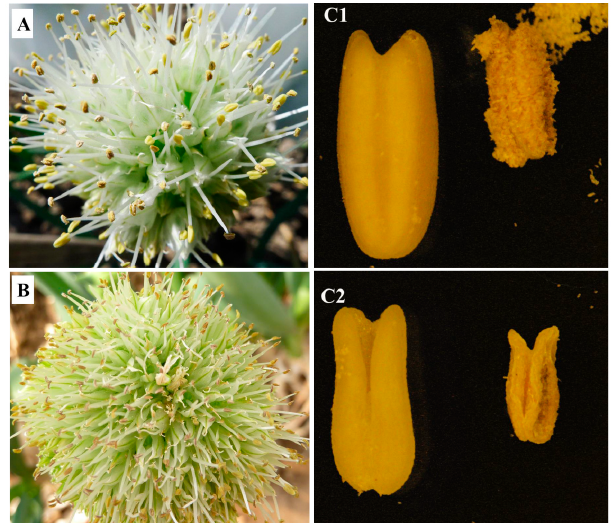
Figure 6. Comparison of cytoplasmic male maintainer and sterile varieties: ( A ) 64-1, cytoplasmic male maintainer; and ( B ) 64-2, cytoplasmic male sterility; ( C1 ) 64-1 cytoplasmic male maintainer anther; and ( C2 ) 64-2 cytoplasmic male sterility anther.